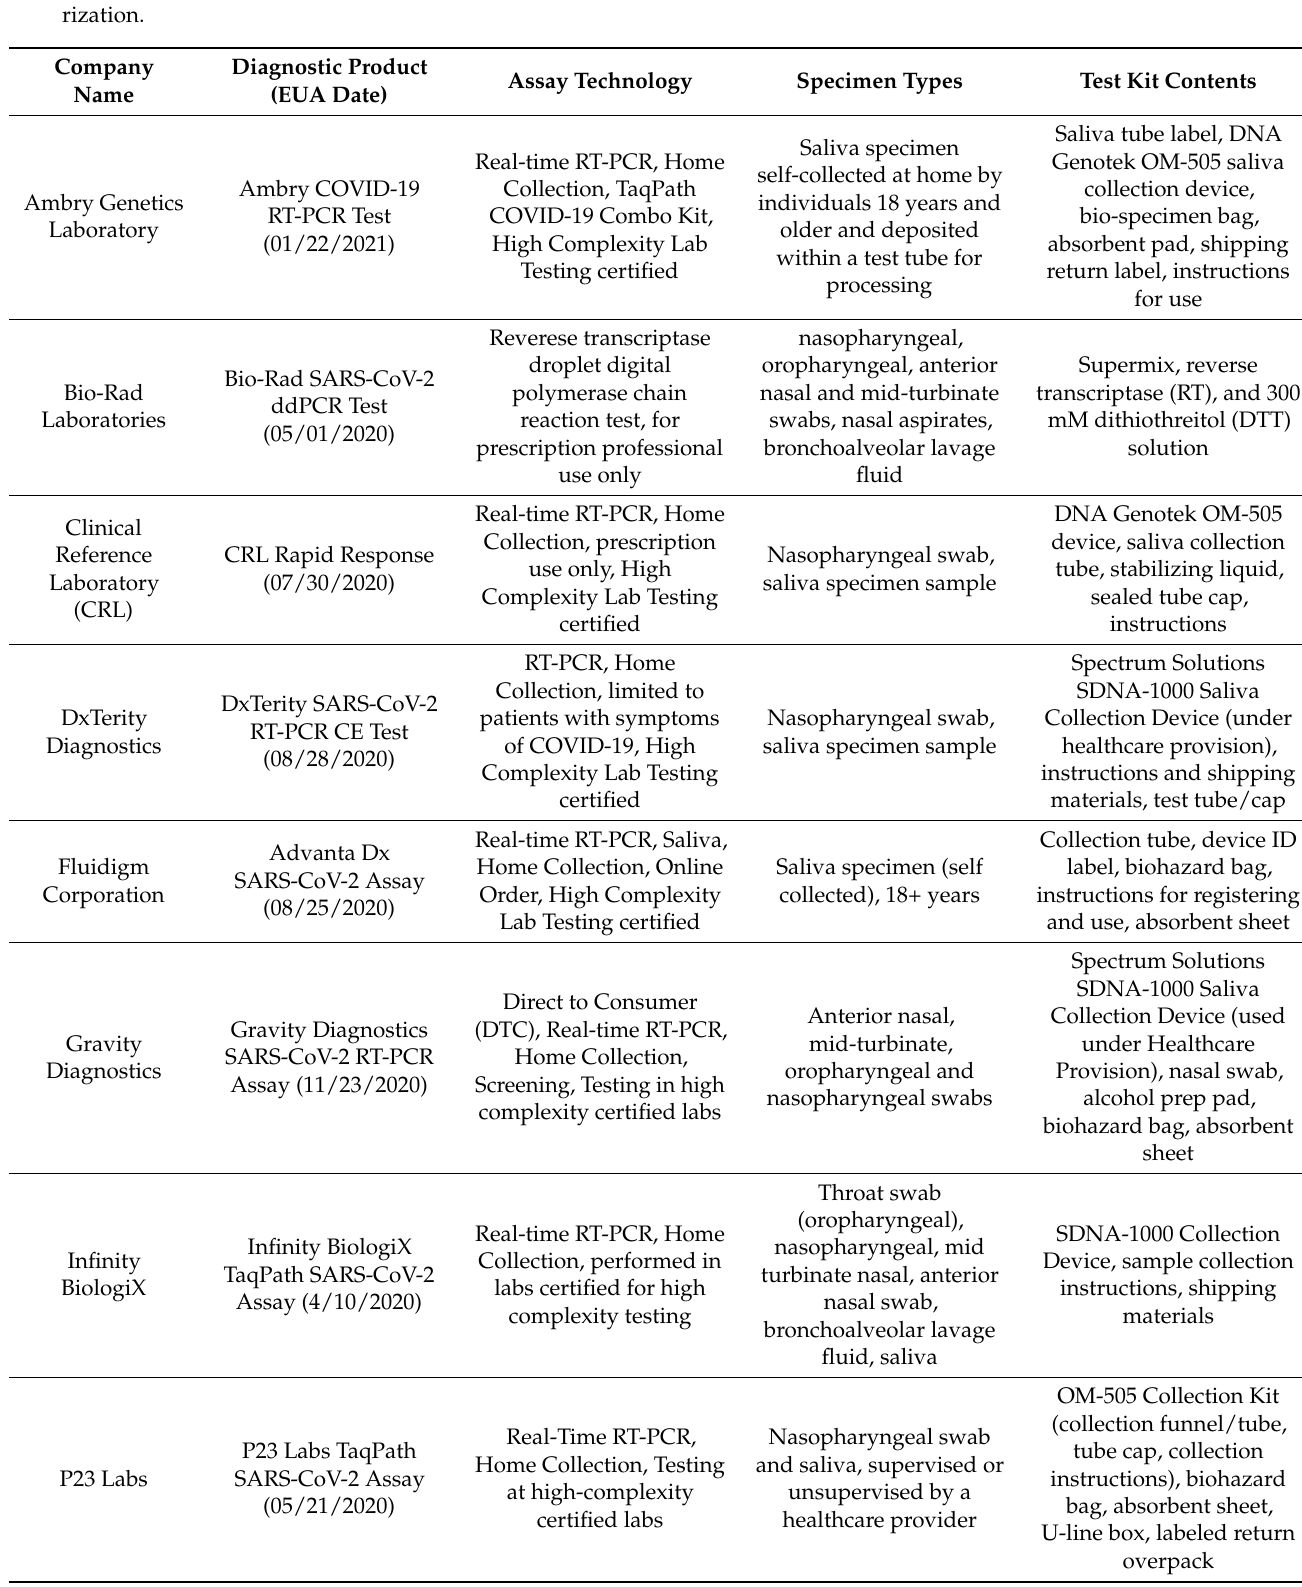
Table 2. At-Home Molecular Diagnostic (RT-PCR) Tests using Saliva Specimens and granted FDA Emergency Use Autho-